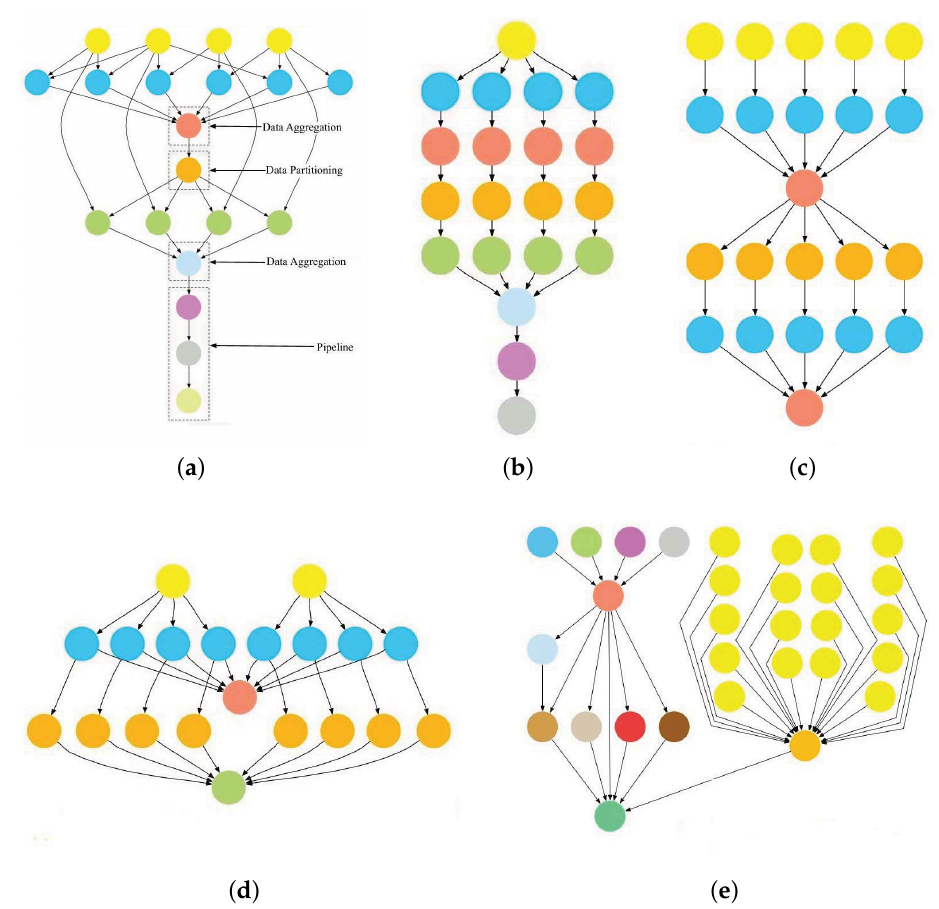
Figure 5. DAG diagrams of workflows with about 30 tasks. ( a ) Montage. ( b ) Epigenomics. ( c ) Inspiral. ( d ) CyberShake. ( e )